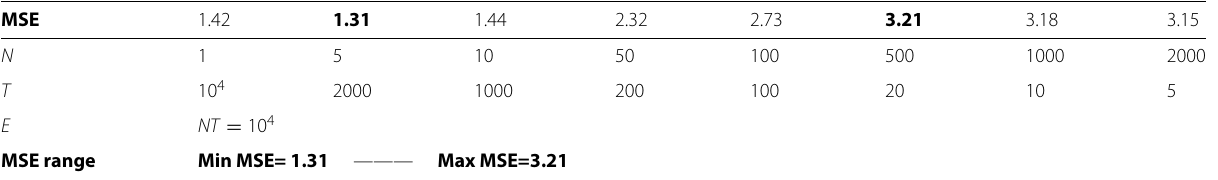
Table 12 Results of N parallel MH chains with a random-walk proposal PDF for the example in Section 6.4